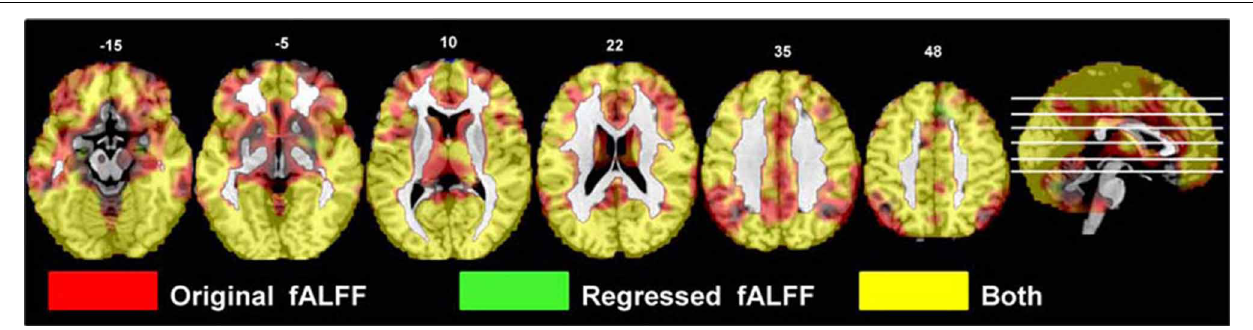
respectively). All suprathreshold voxels for a contrast are shown in the same color. The areas in each cluster that are yellow are areas where the effect of diagnosis passes the significance threshold in both the original and regressed fALFF data.